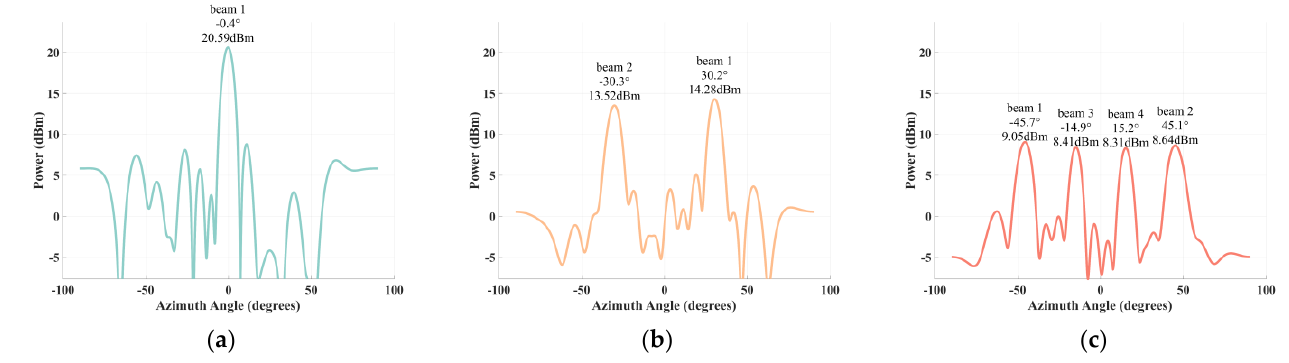
Figure 6. The multi − beam pattern in amplitude and phase inconsistency with the variances are 1 dB and 1 ps. ( a ) single − beam mode; ( b ) dual − beam mode; ( c ) four − beam